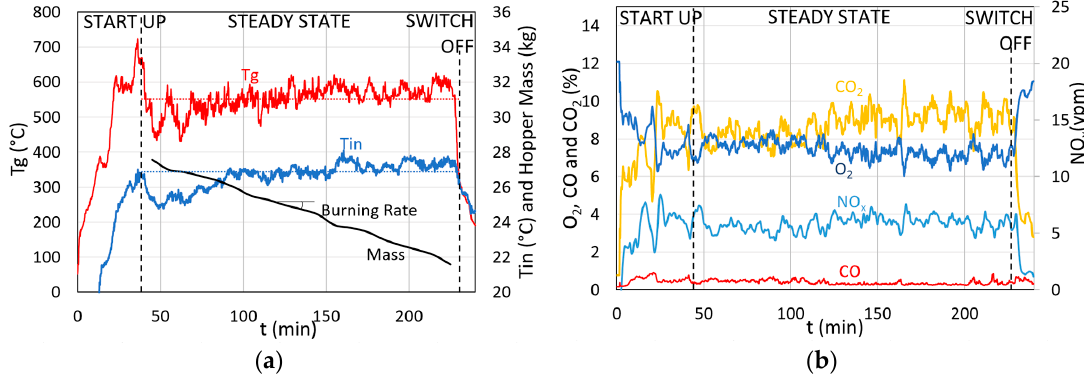
. = 0.457 kg/m 2 s; m (cid:48)(cid:48) air